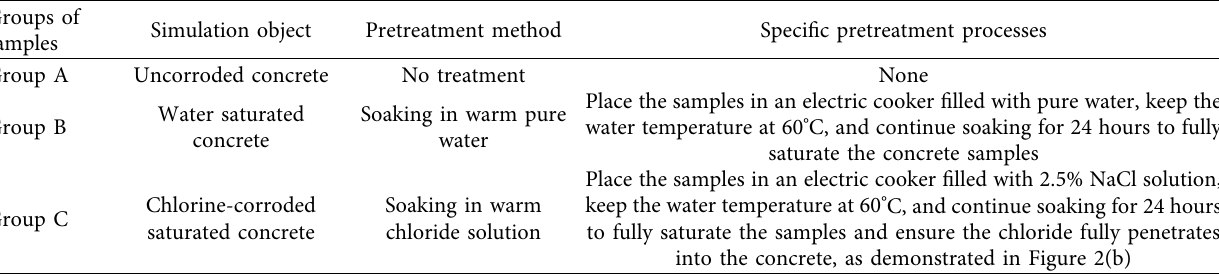
Figure 2: The procedure of triaxial compression test: (a) concrete samples, (b) soaking the samples in an electric cooker, (c) RMT-150B test system, and (d) samples after mechanical tests. Table 1: The pretreatment methods for the three groups of concrete